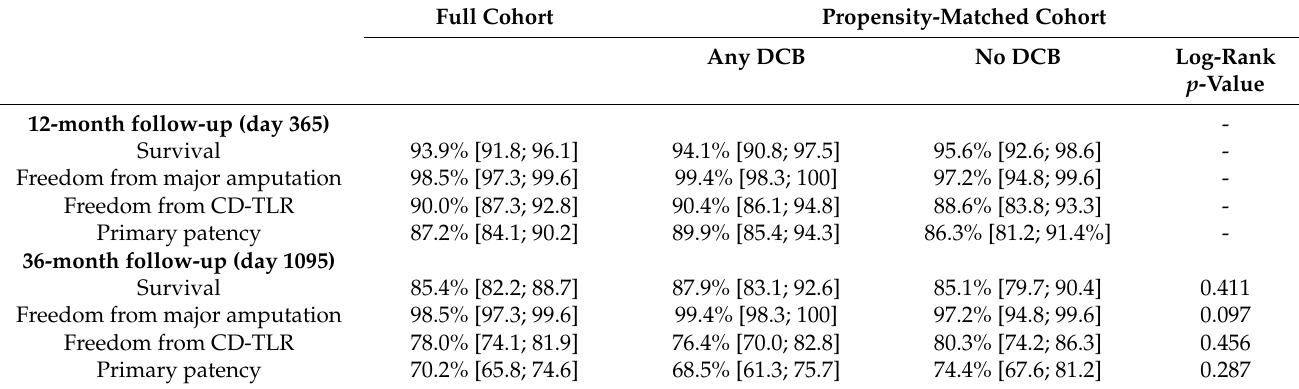
Table 4. Clinical outcomes per Kaplan–Meier analysis.